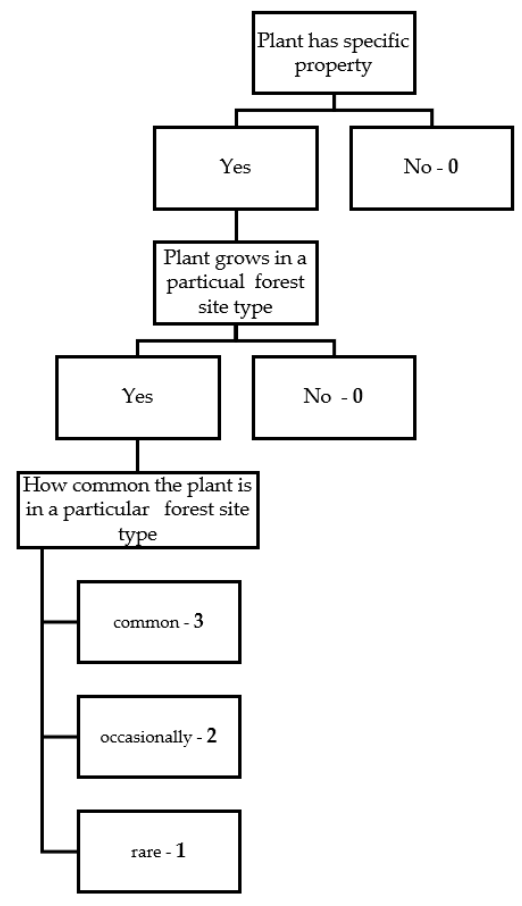
Figure 3. Formula for estimating the indicator of potential plant presence.